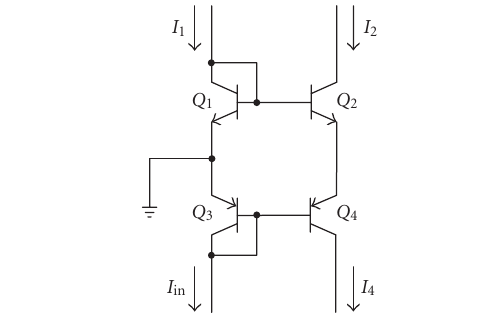
Figure 1: Dual translinear loop.